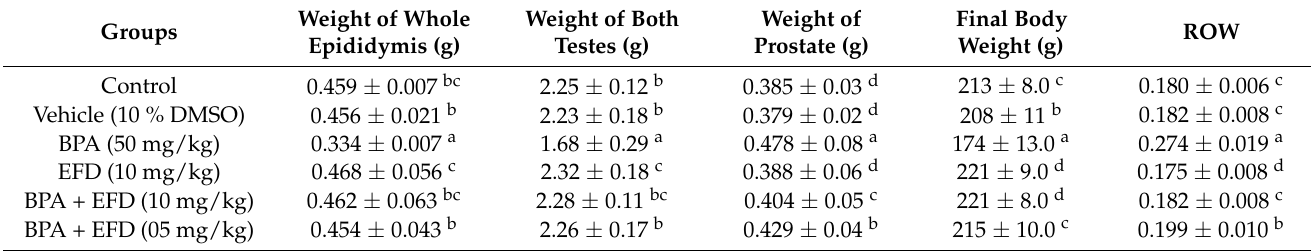
Table 2. Assessment of size, weight and ROW of prostate after EFD treatment.